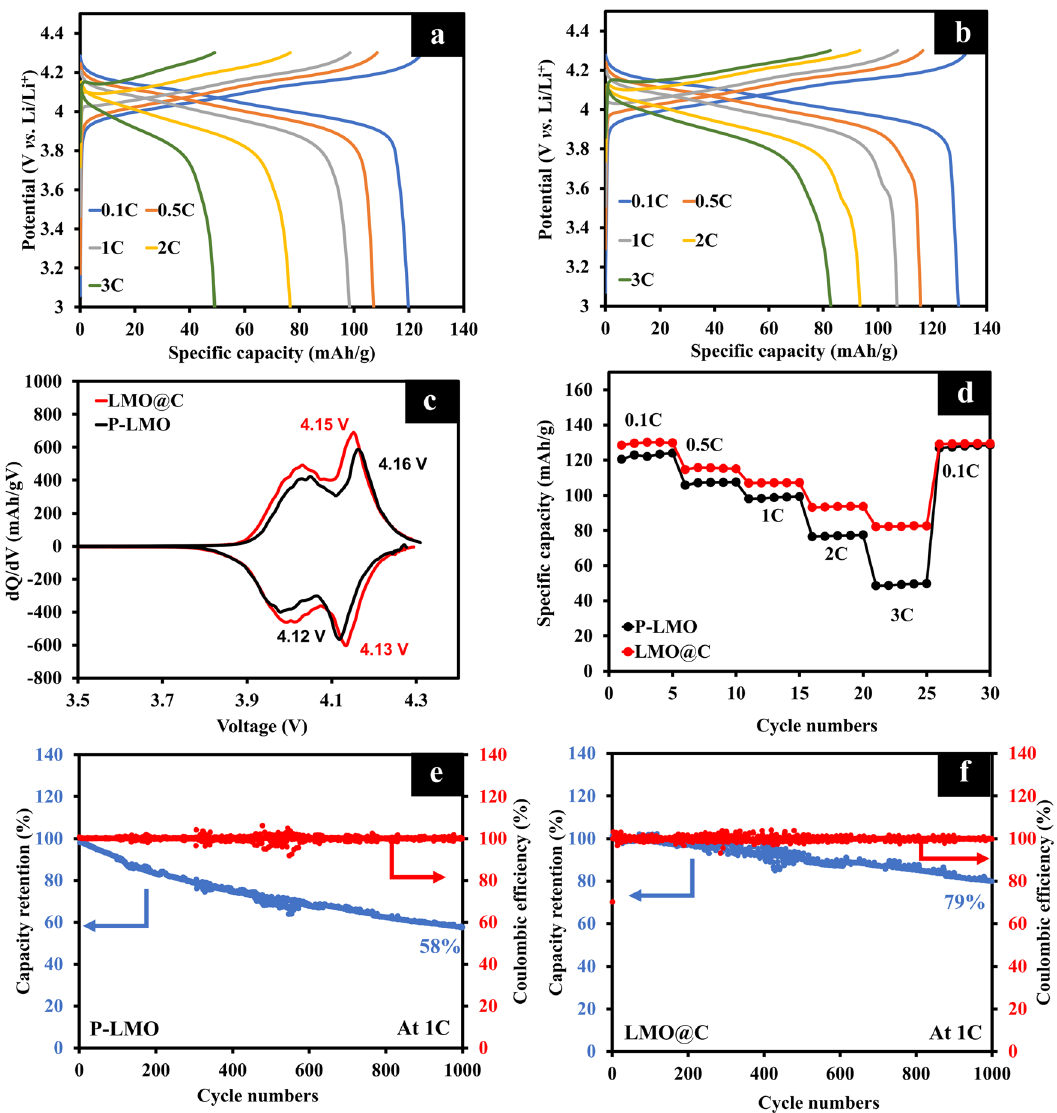
Fig. 3 Electrochemical performance of half-cell con fi gurations for Li//P-LMO and Li//LMO@C. a – b Galvanostatic charge/discharge curves at different C-rates of ( a ) P-LMO and ( b ) LMO@C. c The dQ/dV curves of P-LMO and LMO@C. d The rate capability of P-LMO and LMO@C. e – f The cycling stability test of ( e ) P-LMO, and ( f ) LMO@C